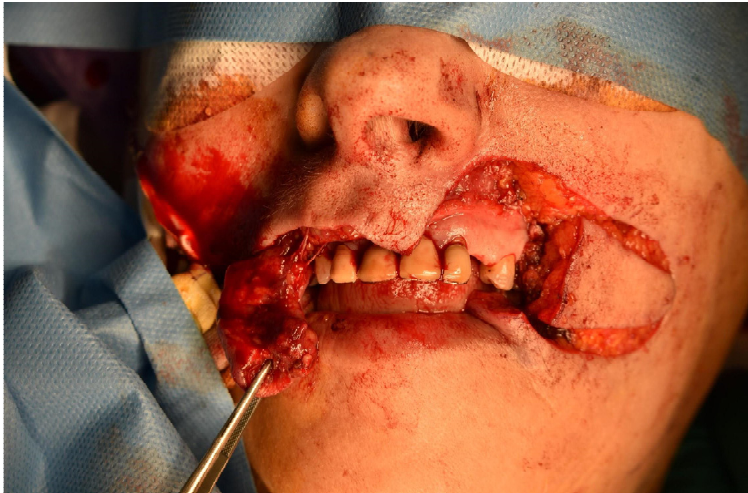
Figure 12. Defect involving 30% of the left upper lip and reconstruction by the new technique.